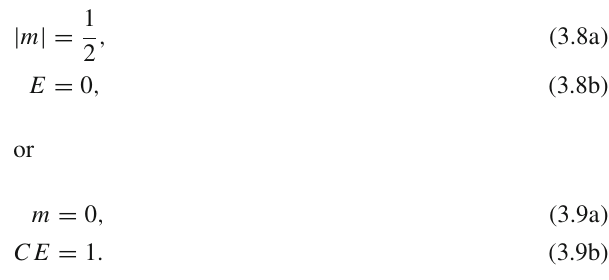
Fig. 1 The discriminant (3.4) obtained with E = 1 . 02 and C = 1. It is clear that (cid:9) assumes either positive, negative, or vanishing values